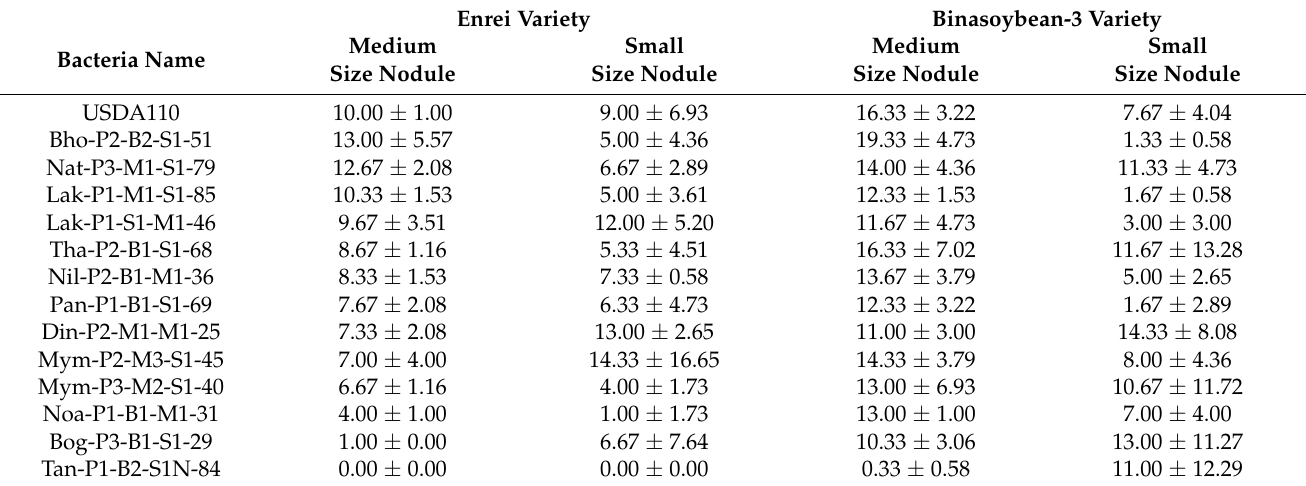
Figure 6. Multi-locus sequence analysis of the atpD , glnII , and the gyrB gene of selected Bradyrhizobium isolates with reference strains. The percentage of trees in which the associated taxa clustered together after 1000 Bootstrap replications is shown next to the branch points. Table 2. Data of medium size (2–5 mm) and small size (<2 mm) nodule number of soybean Enrei variety and Binasoybean-3 variety Inoculated with selected isolates and B. diazoefficiens USDA110. All experiments were performed in triplicate and the data are presented as the mean ±